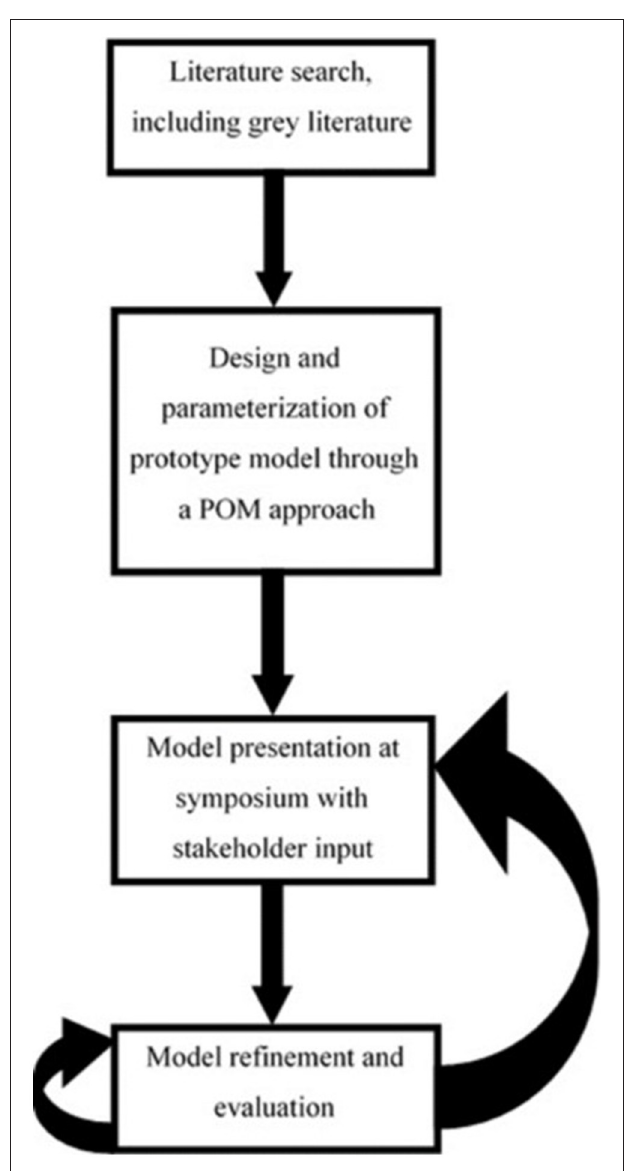
FIGURE 1 | A schematic representation of the modeling process, from initial literature search to the proposed next steps. Model refinement and evaluation is iterative, reflecting the alterations that are constantly made to the model during the calibration process. Once refined, this model should then be reintroduced to stakeholders for further